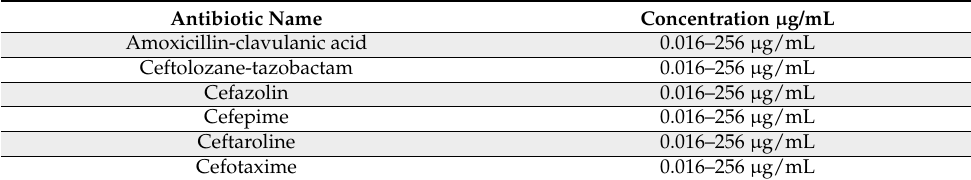
Table 1. The antibiotics used for the E-test and their